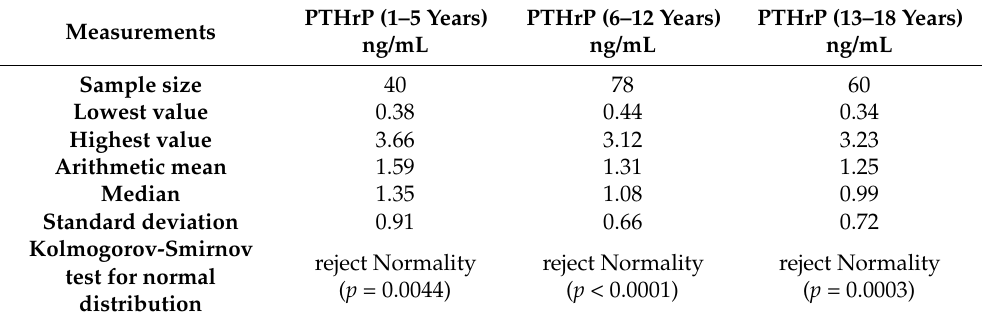
Table 3. Summary statistics of PTHrP values in all subjects and stratified by three age